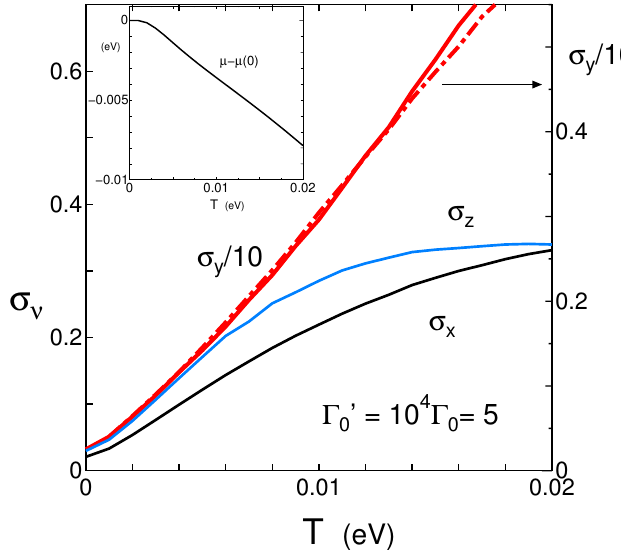
Figure 3. (Color online) Temperature dependence of conductivity of σ ν ( ν = x , y , and z ) with Γ (cid:48) = 10 4 Γ = 5, where R = 0. The dot-dashed line denotes σ y , which is calculated with the fixed 0 0 µ = µ ( 0 ) = 0.5053 eV. The inset denotes temperature dependence of µ ( T )